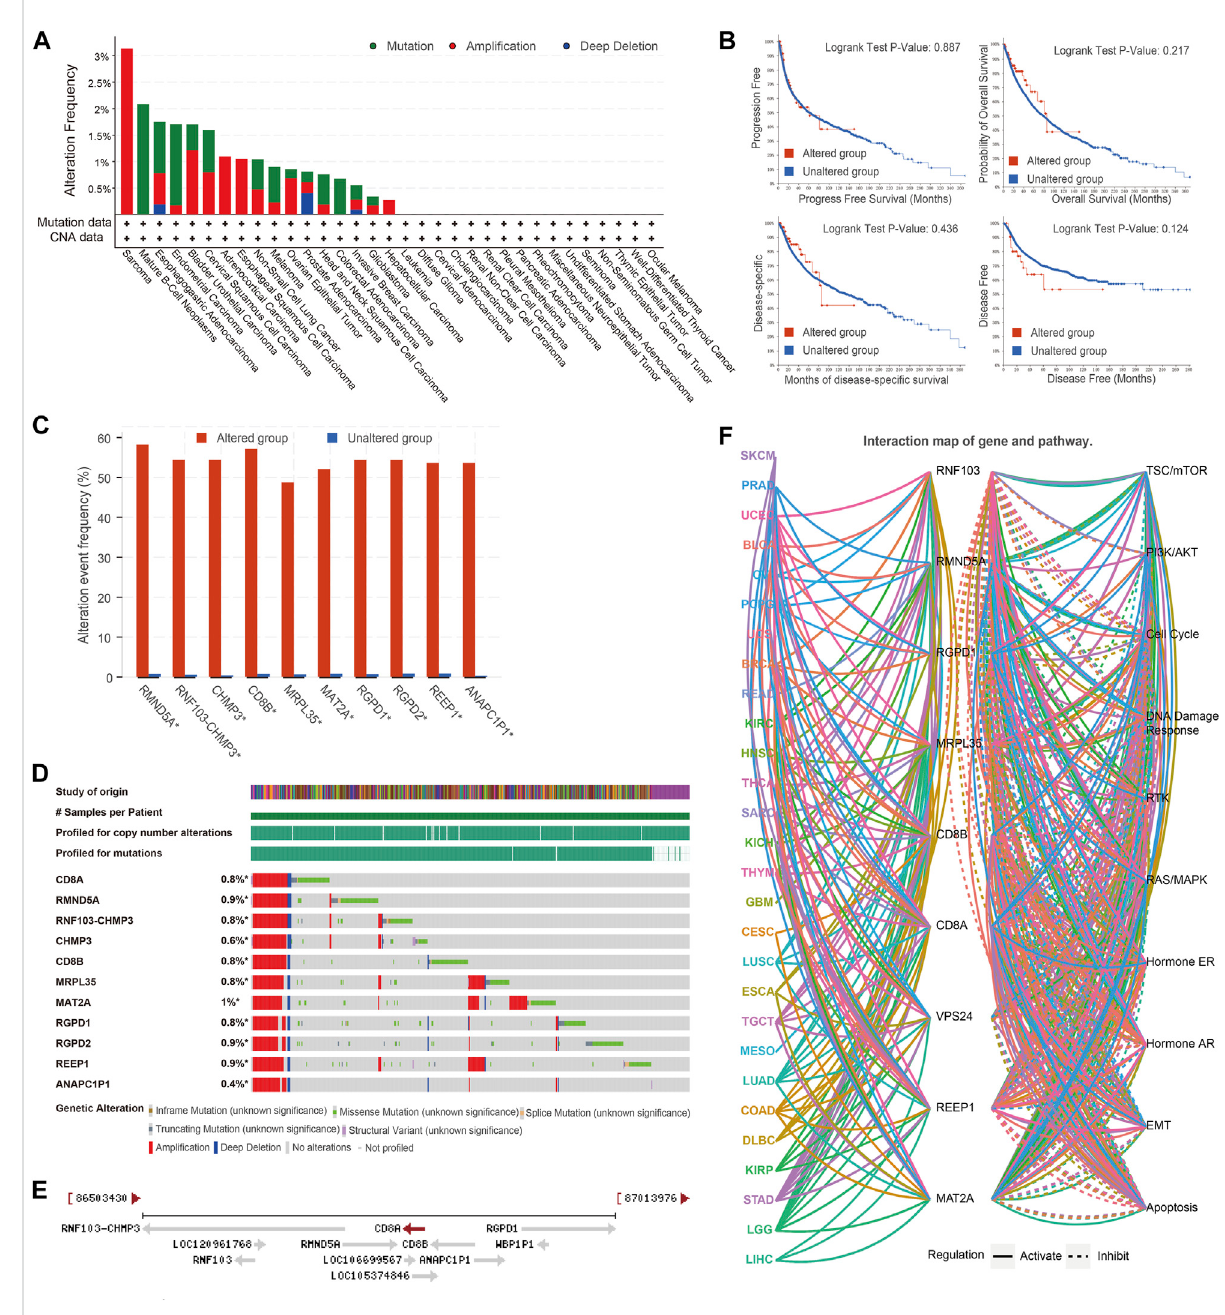
FIGURE 6 Genomicalterationpro fi les,co-occurrencepatternsofCD8Amutationsanditsroleintumorigenesis (A) Genomicalterationpro fi lesofCD8Ain varying cancer types (B) Kaplan-Meier curves analyses of altered and unaltered CD8A groups of pan-cancer datasets in TCGA database (C) Co- occurrence frequency with CD8A alterations (D) Co-occurrence pattern of CD8A alterations (E) Chromosomal location of co-occurrence genes with CD8A (F) The role of co-occurrence genes in regulating cancer-related signaling pathways across various cancer